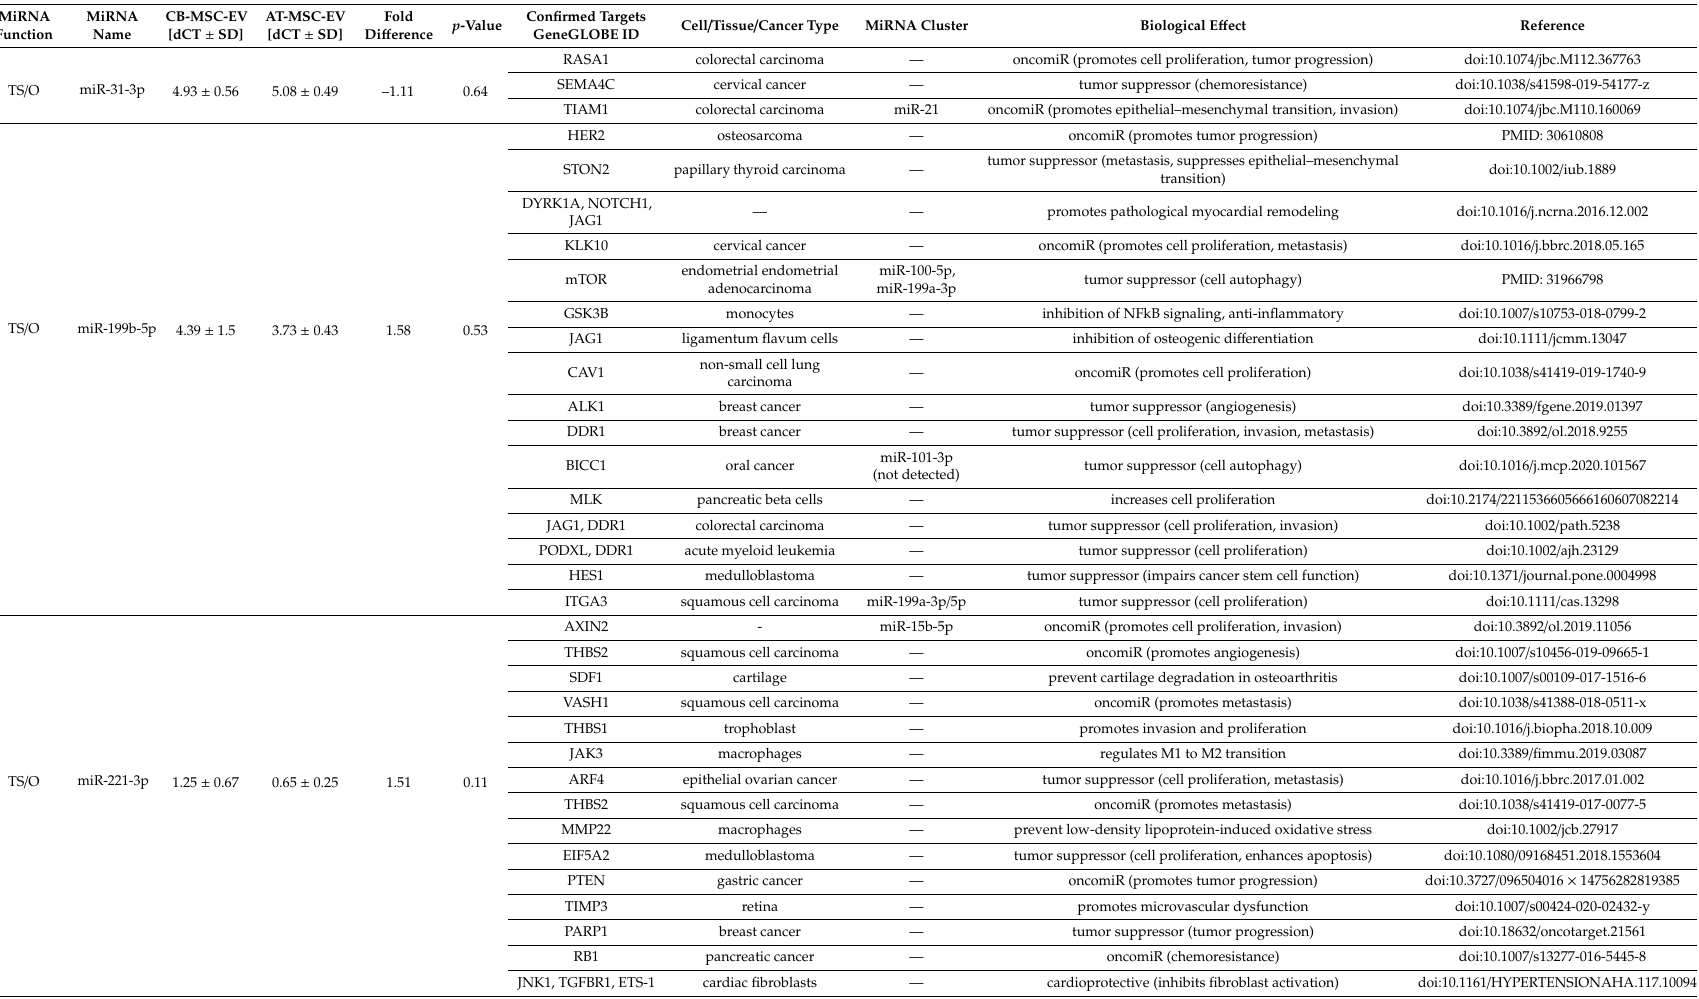
Table A3. MiRNAs that are known for their tumor suppressor and oncogenic potential (TS / O). Selected miRNAs are also involved in cardioprotection (CP). Targets are given for each miRNA, with no claim to completeness. Pubmed IDs (PMIDs) are given as references when no doi numbers are